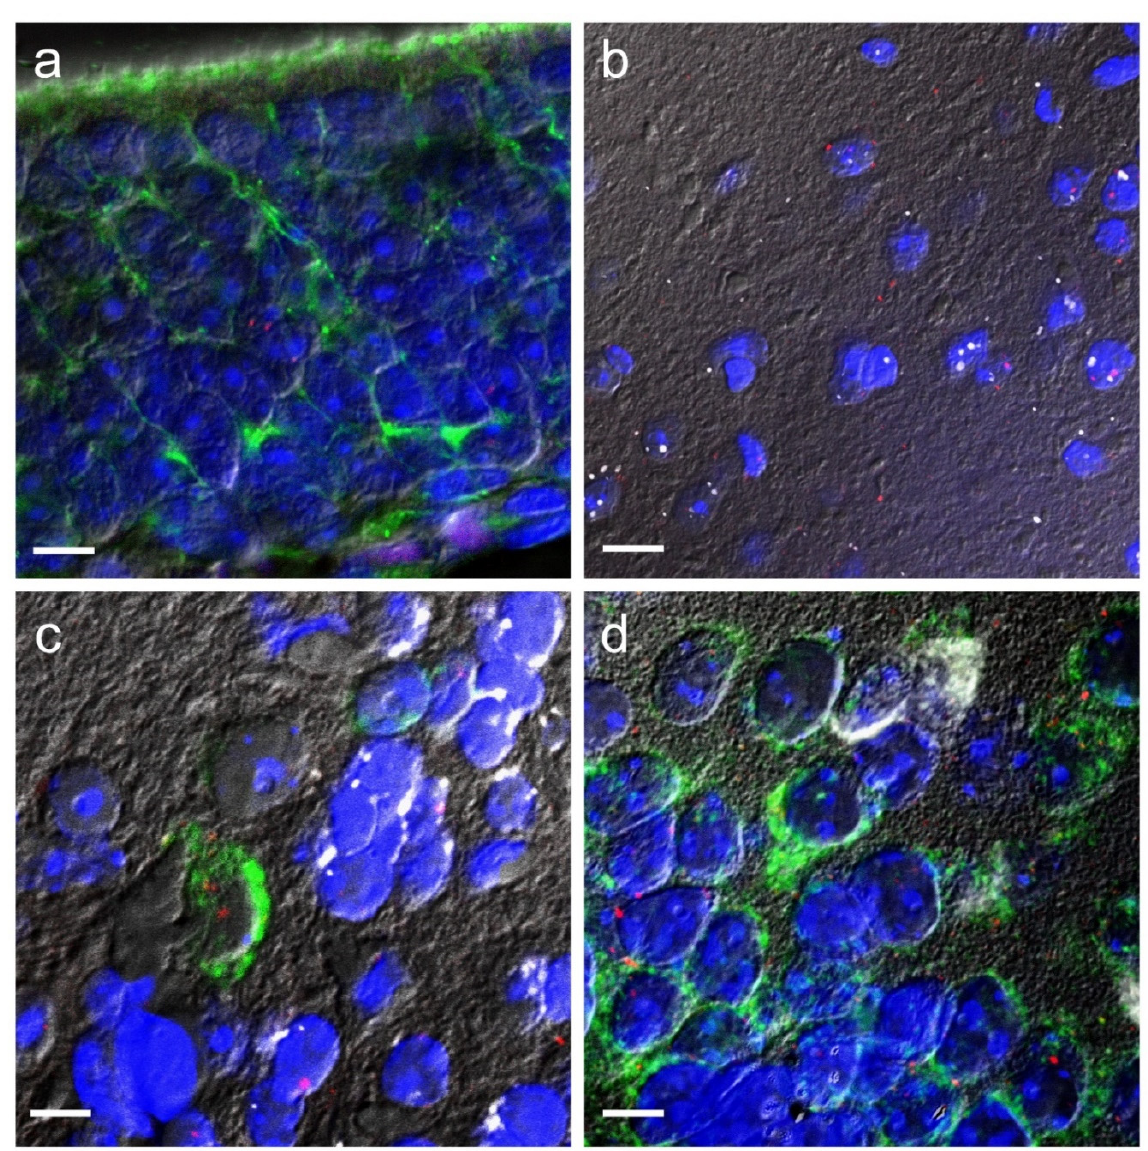
Figure 2. Expression of Trpa1 mRNA in the investigated regions of the olfactory system of C57BL/6 mice ( n = 4). Trpa1 (red) mRNA signal did not colocalise with β -tubulin III (green) immunorective cells in the OE ( a ). Trpa1 (red) mRNA signal colocalised exclusively with NeuN (white) positive neurons in the OB ( b ). Trpa1 (red), Gad1 (white) and Vglut1 (green) mRNA expression in the OB (Bregma 3 mm), ( c ) and in the PC ( d ) (Bregma − 1.46 mm). Trpa1 mRNA signal colocalised both with Gad1 and Vglut1 positive neurons in the OB ( c ), but it colocalised only with Vglut1 positive neurons in the PC ( d ) . Cell nuclei were counterstained with DAPI (blue) in all areas. Abbreviations: NeuN: neuronal nuclear protein, Gad1: glutamate decarboxylase 1, Vglut1: vesicular glutamate transporter 1, DAPI: 4 ′ ,6-diamidino-2-phenylindole. In order to highlight the cell borders, differential interference contrast (DIC) images were merged with the virtual color images. Bars: 10 µm